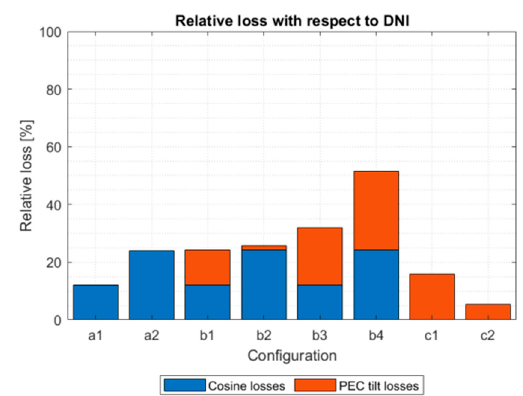
Figure 4. Relative losses with respect to DNI, caused by the collector cosine effect (blue) and the PEC(-PV) tilt constraints (red) for geometrical configurations listed in Table 5 and applied PEC(-PV) device tilt constraints (Figure 1c). Location: Seville, Spain.